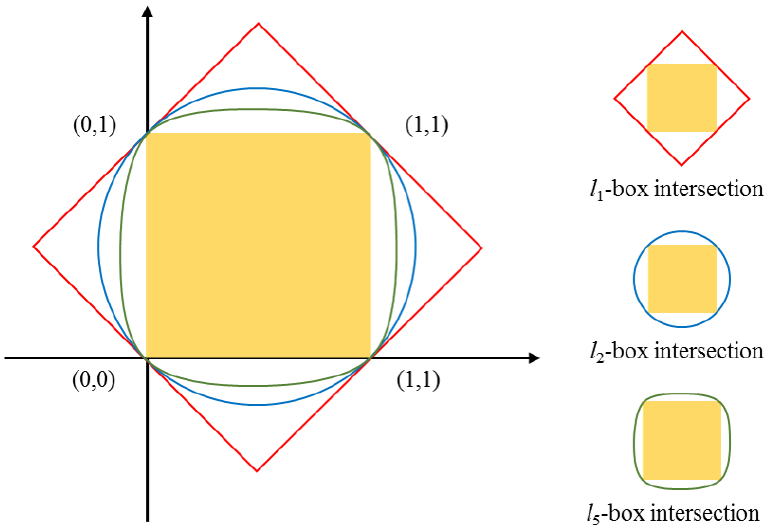
Figure 7. The geometric illustration of the l p -box in R 2 .